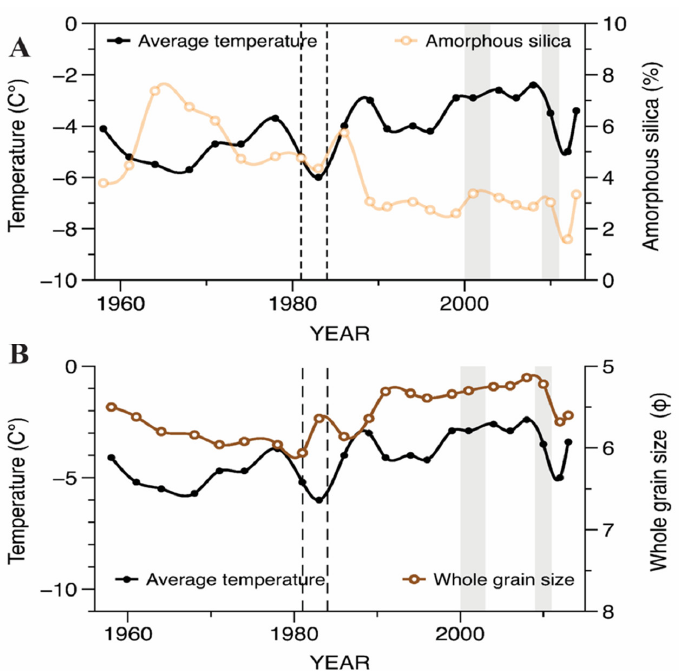
Figure 7. Comparison between meteorological data and sediment characteristics of Olgoy lake. ( A ) Temperature versus amorphous silica content and ( B ) temperature versus whole grain size. The drought combined with the dzud record is covered with a dashed line, and the white dzud is highlighted in gray.